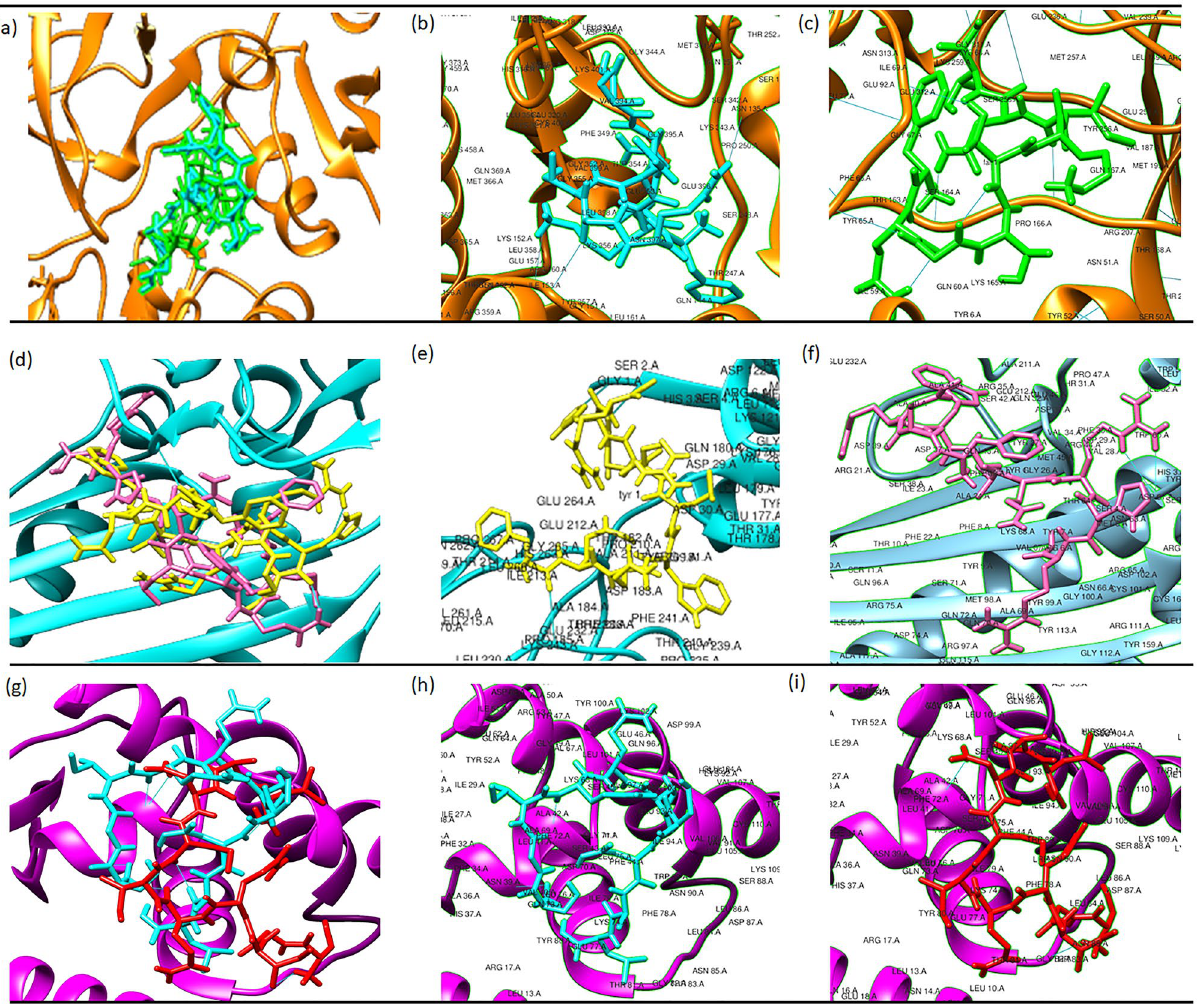
Figure 5. Images of the superimposed native and mutant structural models docked against target proteins with high probabilities values that affect protein functions. ( a ) Superimposed image of SRC (orange) docked against native (blue) and mutant (green) FARP2 protein and interaction of SRC with ( b ) native and ( c ) mutant FARP2 protein structures. ( d ) Superimposed image of DCT (blue) docked against native (yellow) and mutant (pink) TYR protein and interaction of DCT with ( e ) native and ( f ) mutant TYR protein structures. ( g ) Superimposed image of MYNN (purple) docked against native (blue) and mutant (red) LRRC34 protein and interaction of MYNN with ( h ) native and ( i ) mutant LRRC34 protein structures. Hydrogen bonds are presented in a straight blue